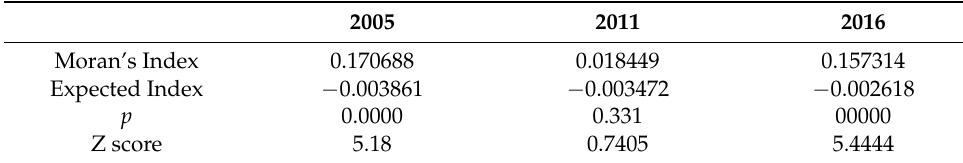
Table 3. Results of the spatial autocorrelation analysis.